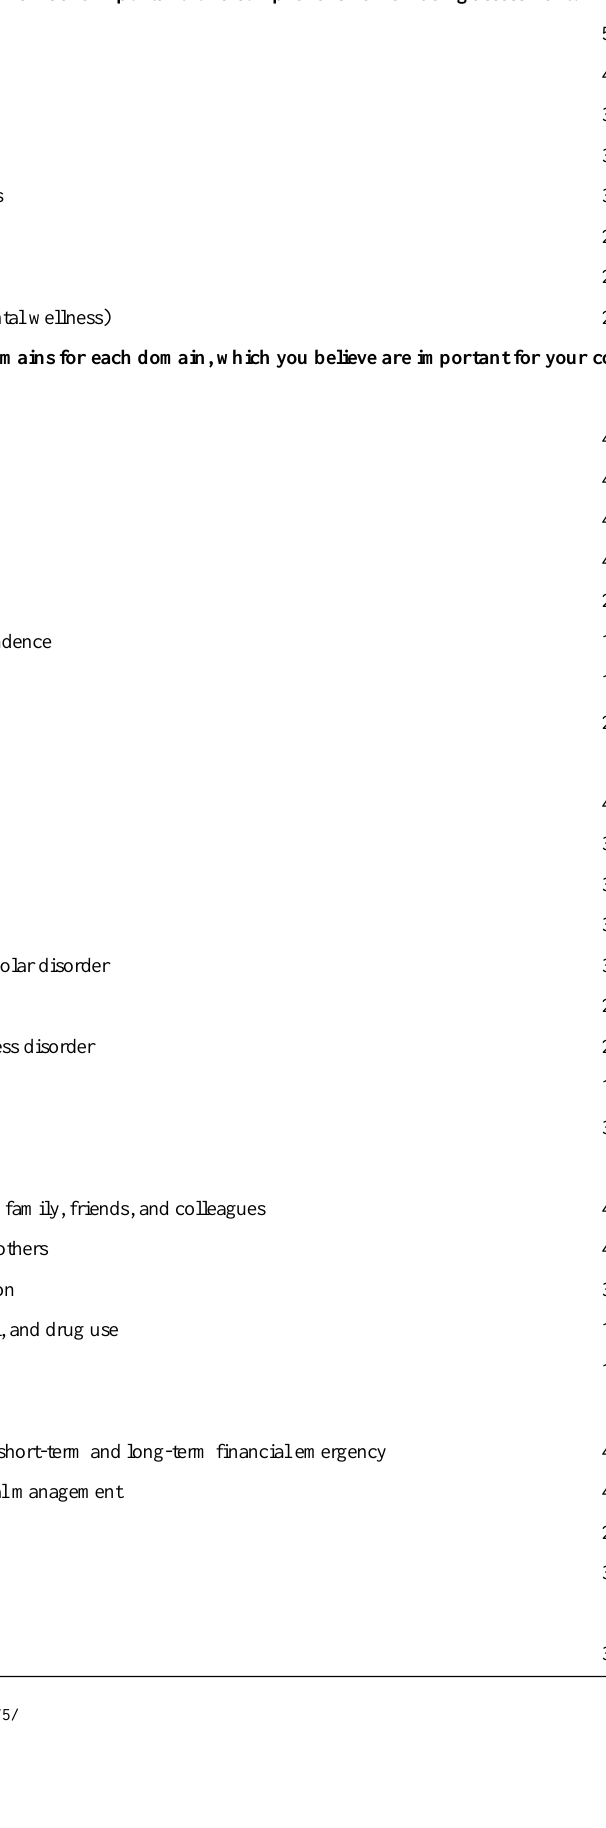
Table 2. Summary of answers from the study participants in the first questionnaire study (N=518). Which of the following domains are important for a comprehensive well-being